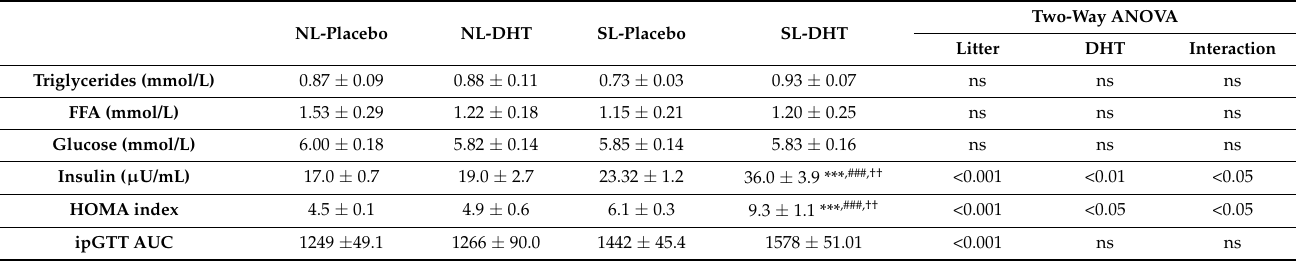
Table 2. Lipid status and systemic insulin sensitivity parameters of DHT treated and placebo rats from small litters (SL) and normal litters